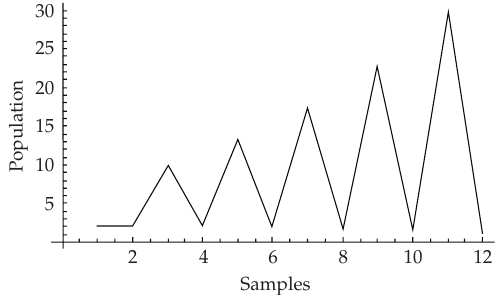
Figure 5: μ (cid:8) 2 , K (cid:8) 200 , γ (cid:8) 0 . 8 , d (cid:8) 0 . 1 x (cid:2) 0 (cid:3) , α (cid:8) 0 . 1 , p (cid:8)